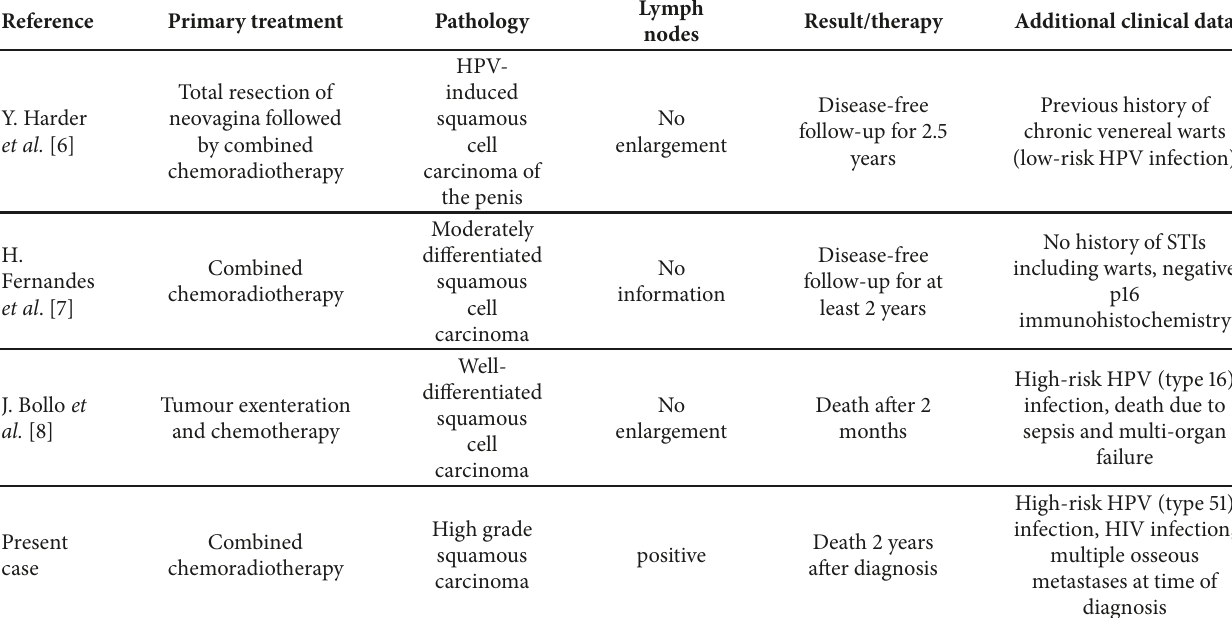
Table 2: Primary treatment, histopathology of tumours and lymph nodes, results of treatment, and additional clinical data.